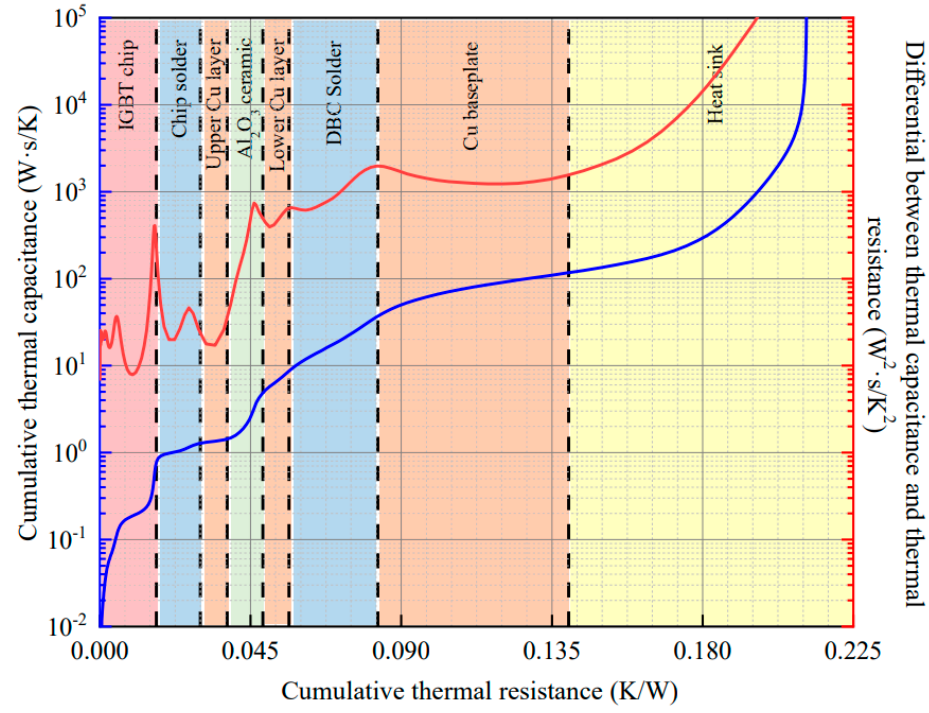
Figure 7. Cumulative and differential structure functions of the IGBT module. Table 1. The thermal resistance and thermal capacitance of each layer of the IGBT module obtained based on the experimental test and the structure function.